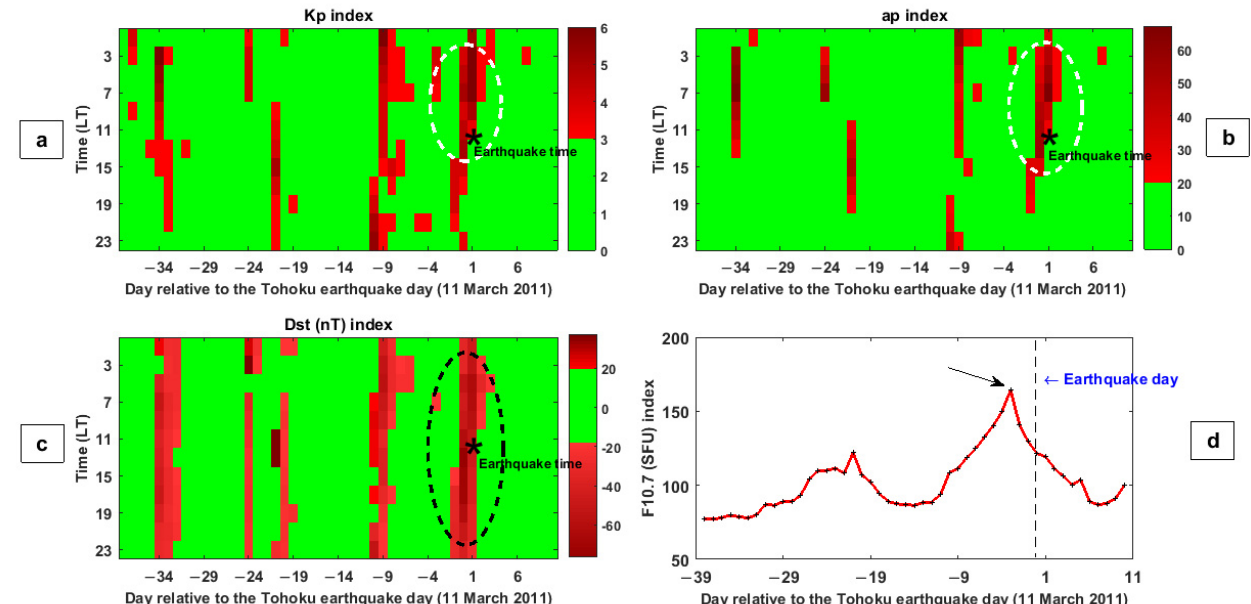
Figure 1. ( a – d ) shows, respectively, the variations of K p , a p , D st , and F10.7 geomagnetic indices during the period of 1 January to 30 April 2011. An asterisk “*” indicates the earthquake time of Tohoku (11 March 2011). The dotted ellipsoids represent the conditions around the earthquake time. The dotted line represents the earthquake day. The x -axis represents the days relative to the earthquake day. The y -axis in a, b, and c represents the local time coordinate. The values of the geomagnetic indices are given as binary, i.e., red for disturbed magnetic times and green for quiet magnetic times.